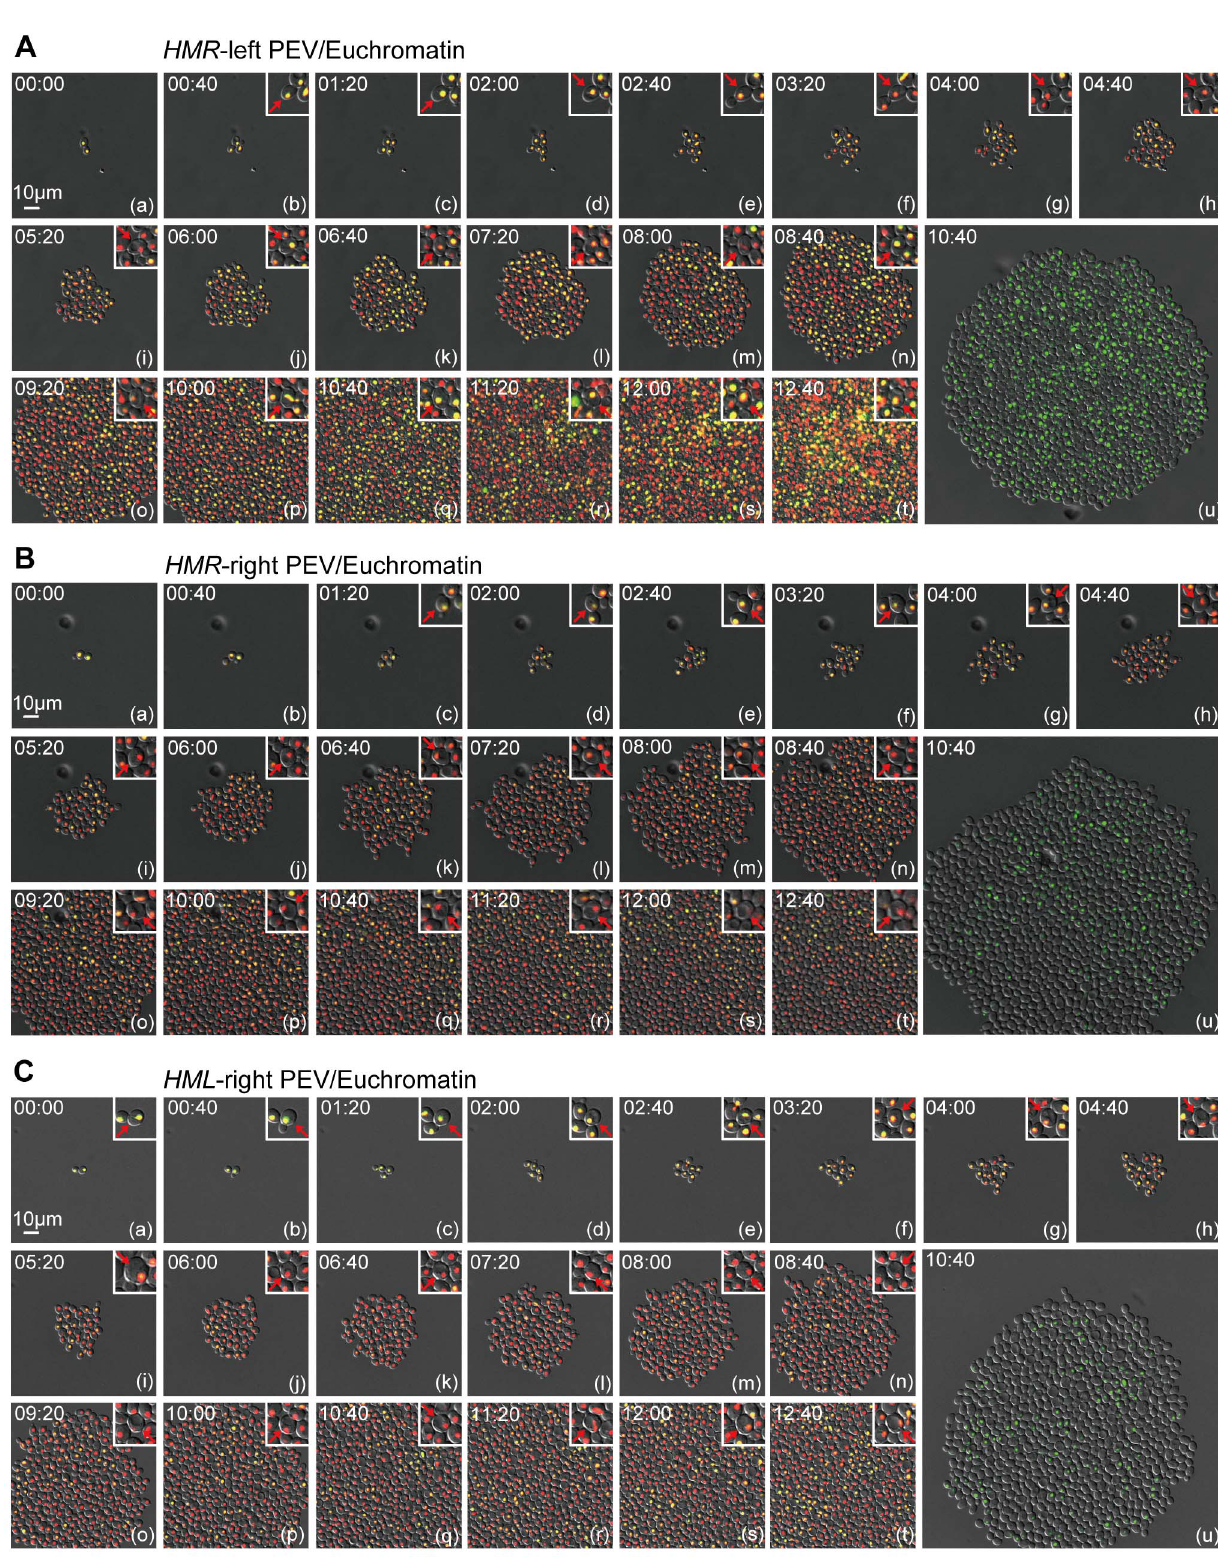
Figure 3. Gene expression states in PEV strains assessed by time-lapse imaging of single yeast cells. Time-lapse images of the HMR -left PEV/Euchromatin (FUY263) (A), HMR -right PEV/Euchromatin (FUY356) (B), and HML -right PEV/Euchromatin (FUY795) (C) strains expressing HTB1-EGFP (green fluorescence) and HTB1-2x mCherry (red fluorescence), same as Figure 2. See also Movies S3.